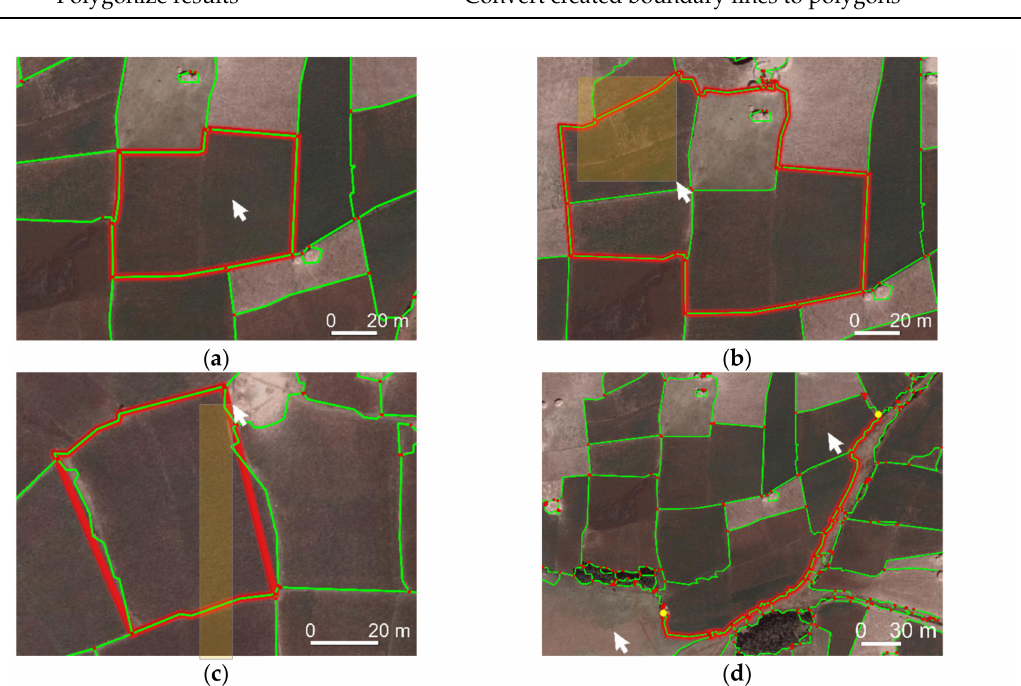
Figure 6. Interactive delineation functionalities: ( a ) Connect lines surrounding a click, or ( b ) a selection of lines. ( c ) Close endpoints of selected lines to a polygon. ( d ) Connect lines along